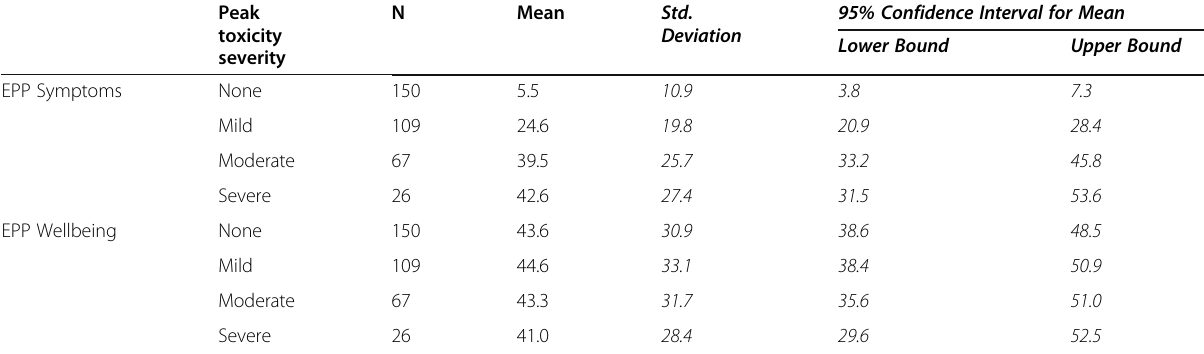
Table 5 EPP-QoL domain scores with respect to peak toxicity severity from previous 60 days